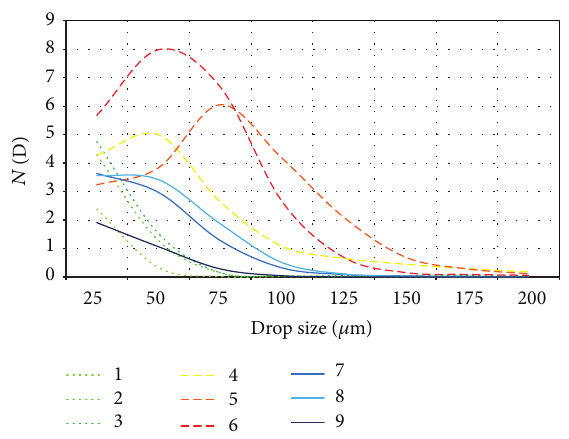
Figure 5: Gamma distribution curves for each of the nine times of Table 1 and Figure 4.